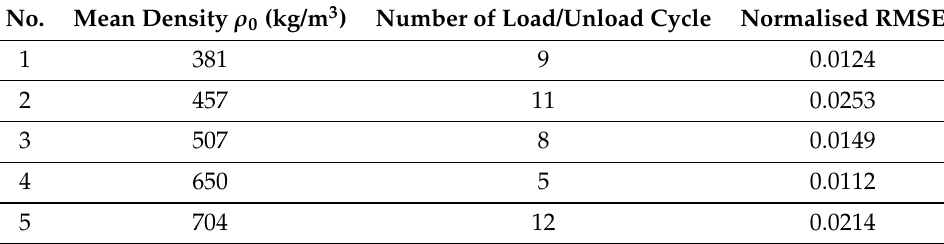
Figure 11. Prediction error for the learning data set. Table 3. Machine learning algorithm results for different concrete